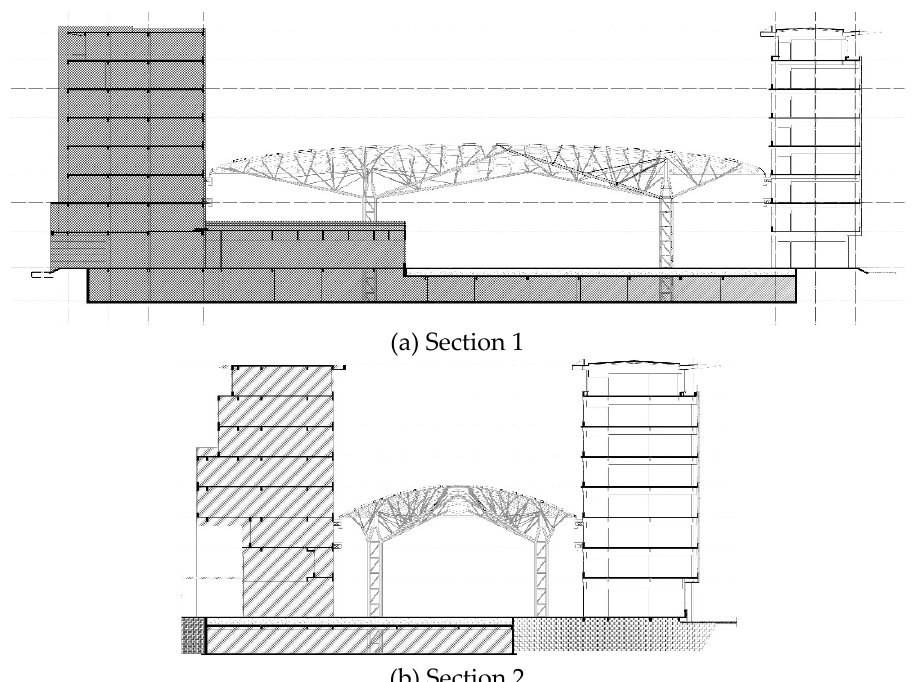
Figure 14. Section of the umbrella-shaped structure.